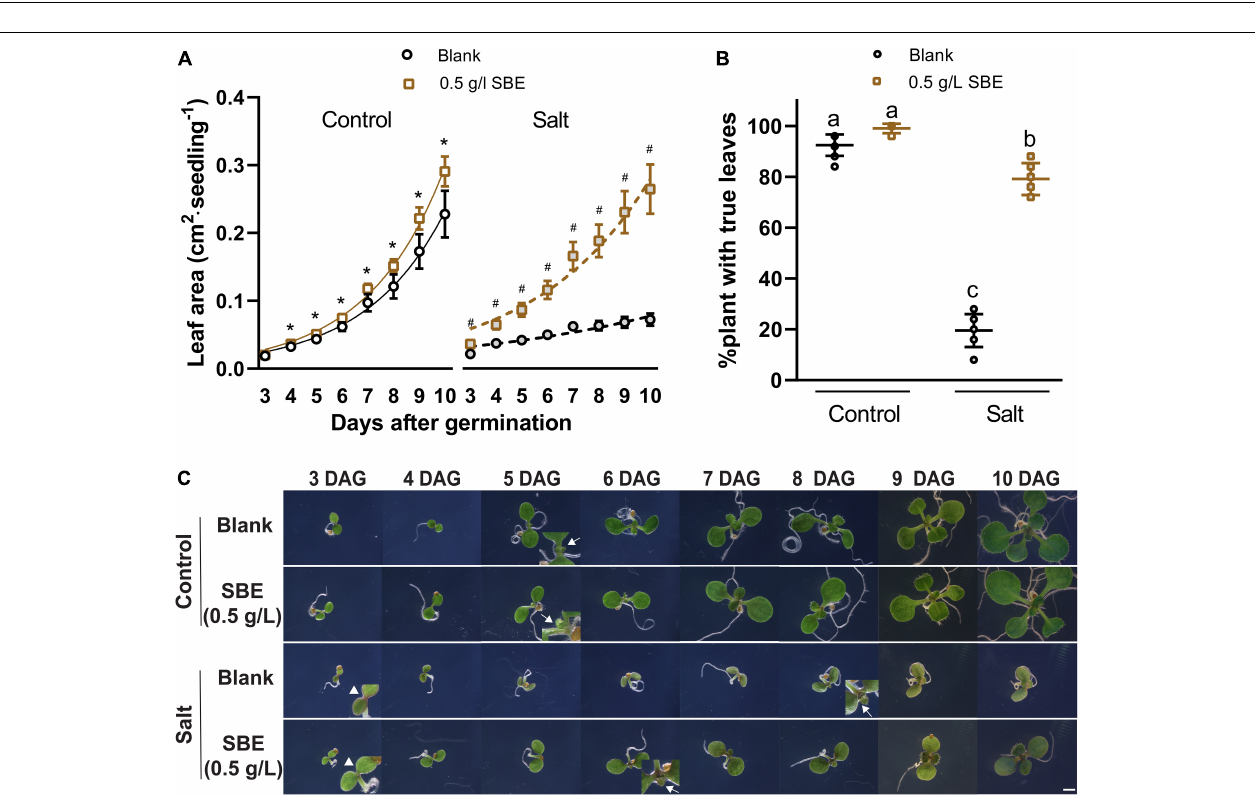
FIGURE 3 | Salt stress alleviation of SBE treatment in the Arabidopsis shoot assay. (A) Phenotypes of representative seedlings at 13 DAG grown on multiwell plates. Bar = 2 mm. The changes of (B) leaf area ( n = 16) and (C) conductivity ( n = 4) of 13 DAG seedlings. Error bars indicate SDs of the means. Different letters represent significant differences between treatments using Tukey’s HSD test ( p < 0.05). SBE, sunflower bark extract; DAG, days after germination.